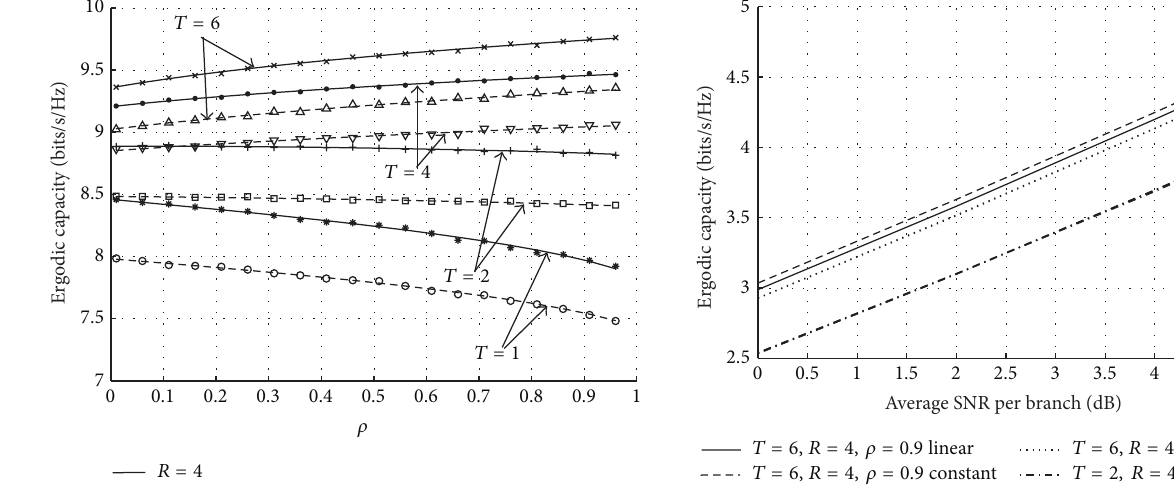
Figure 8: Ergodic capacity versus average SNR per receive antenna; 𝑅 = 4 ; 𝑇 = 2, 6 ; 𝜌 = 0.2, 0.9 ; constant or linear receive array correlation. The cases when the curves overlap and cannot be distinguished are indicated in the